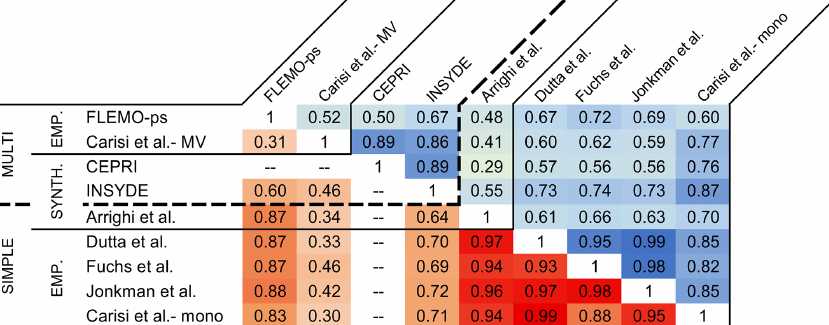
Figure 5. Pearson’s correlation coefficients for absolute-damage estimations (top right of the matrix; in blue) and relative-damage estimations (bottom left of the matrix; in red) supplied by the models with reference to all the buildings in the flooded area (the darker the colour, the stronger the correlation).